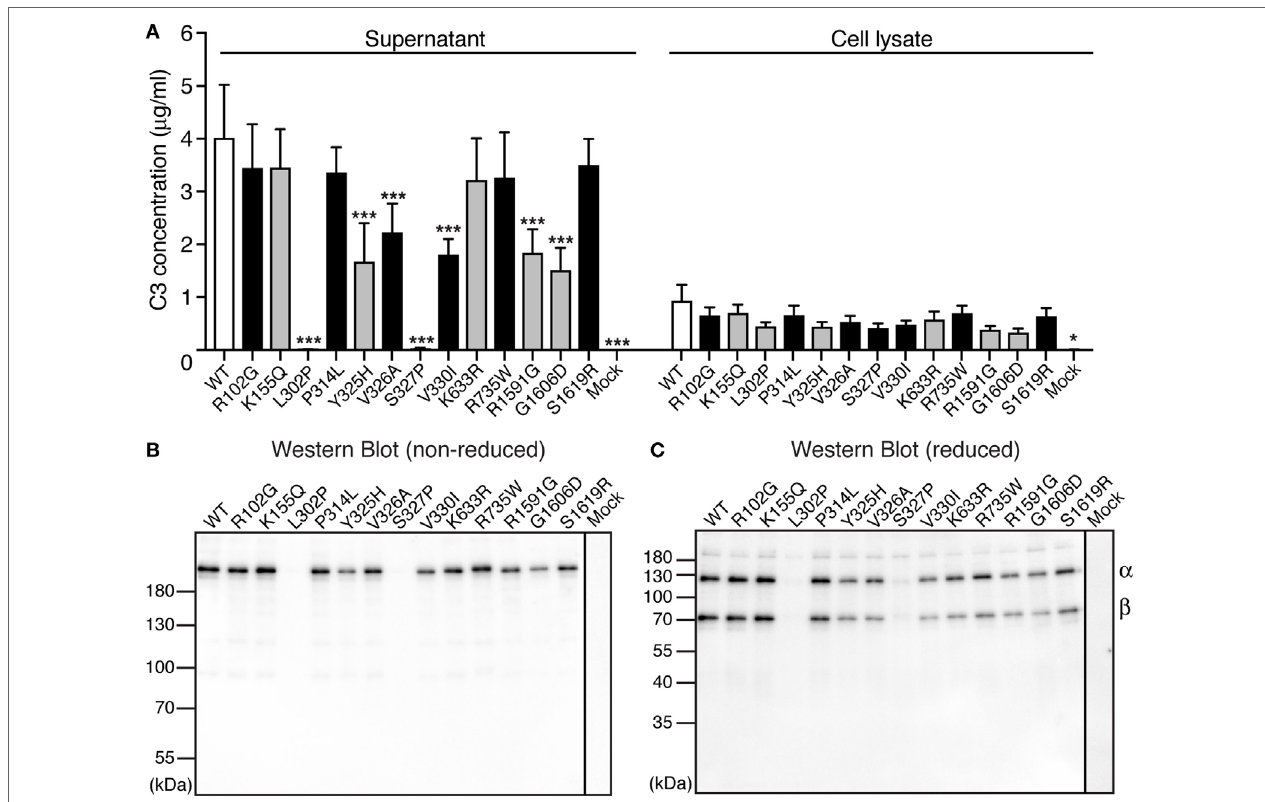
FigUre 1 | Expression of C3 variants. (a) C3 variants, together with wild type (WT) and negative control (mock = empty vector), were transiently transfected into adherent human embryonic kidney (HEK) 293 cells. After four independent transfections, the C3 concentration was measured both in the conditioned cell media (supernatant) and the cell lysate using ELISA. The results are shown as mean + SD and the statistical significance of the differences between WT and mutants was determined using two-way ANOVA with Dunnett’s multiple comparisons test, * p < 0.05, *** p < 0.001. The C3 alterations identified only in patients are marked in gray. (B,c) After transient transfections, the same volume of each cell supernatant was also subjected to SDS-PAGE under both (B) non-reducing and (c) reducing conditions, followed by Western blotting. C3 was detected using a polyclonal anti-C3